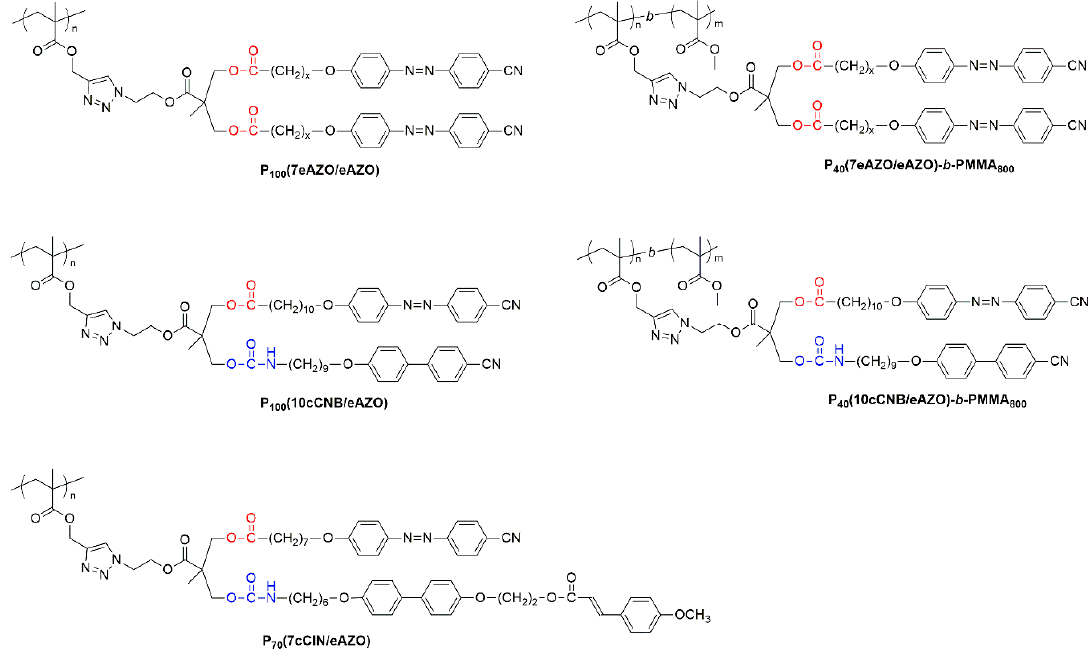
Figure 3. Chemical structure of homo- and block polymers discussed in this work.